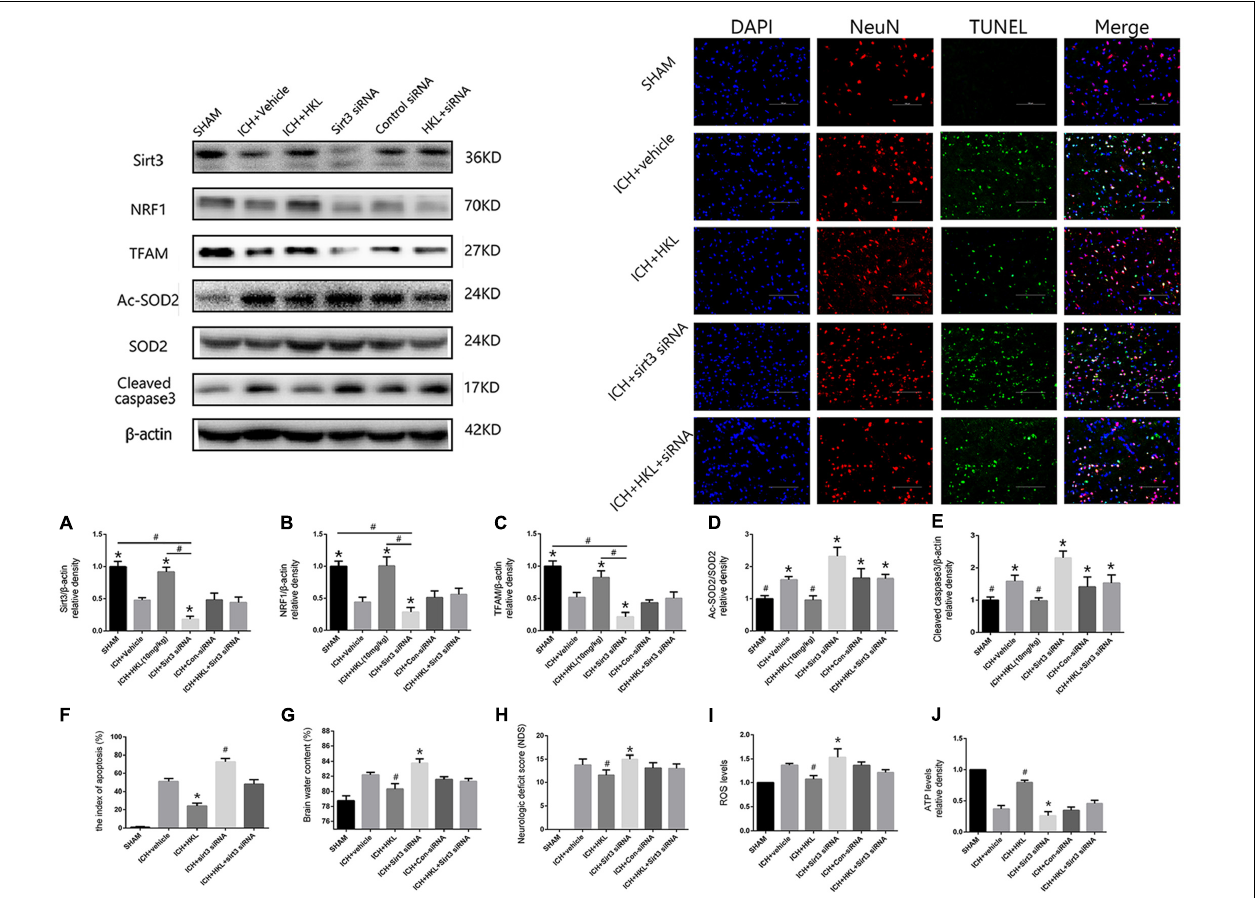
FIGURE 4 | Sirt3 knockdown abolished the positive effects of HKL and exacerbated cerebral injury. (A) Sirt3 expression. (B) NRF1 expression. (C) TFAM expression. ∗ P < 0.05 versus the rest three groups, # P < 0.05 ( n = 6 in each group). (D) Ac-SOD2/SOD2 ratio. (E) Cleaved caspase3 expression. ∗ P < 0.05 versus the rest two groups, # P < 0.05 versus the rest four groups ( n = 6 in each group). (F) Representative co-labeling TUNEL/NeuN pictures of ipsilateral basal ganglia. Quantification of TUNEL-positive neurons (the index of apoptosis = TUNEL-positive neurons/total neurons, n = 6 in each group), Scale bars: 100 µ m. (G) Brain water content. (H) Neurologic deficit scores. (I) ROS levels. (J) ATP levels ∗ P and # P < 0.05 versus the rest groups ( n = 6 in each